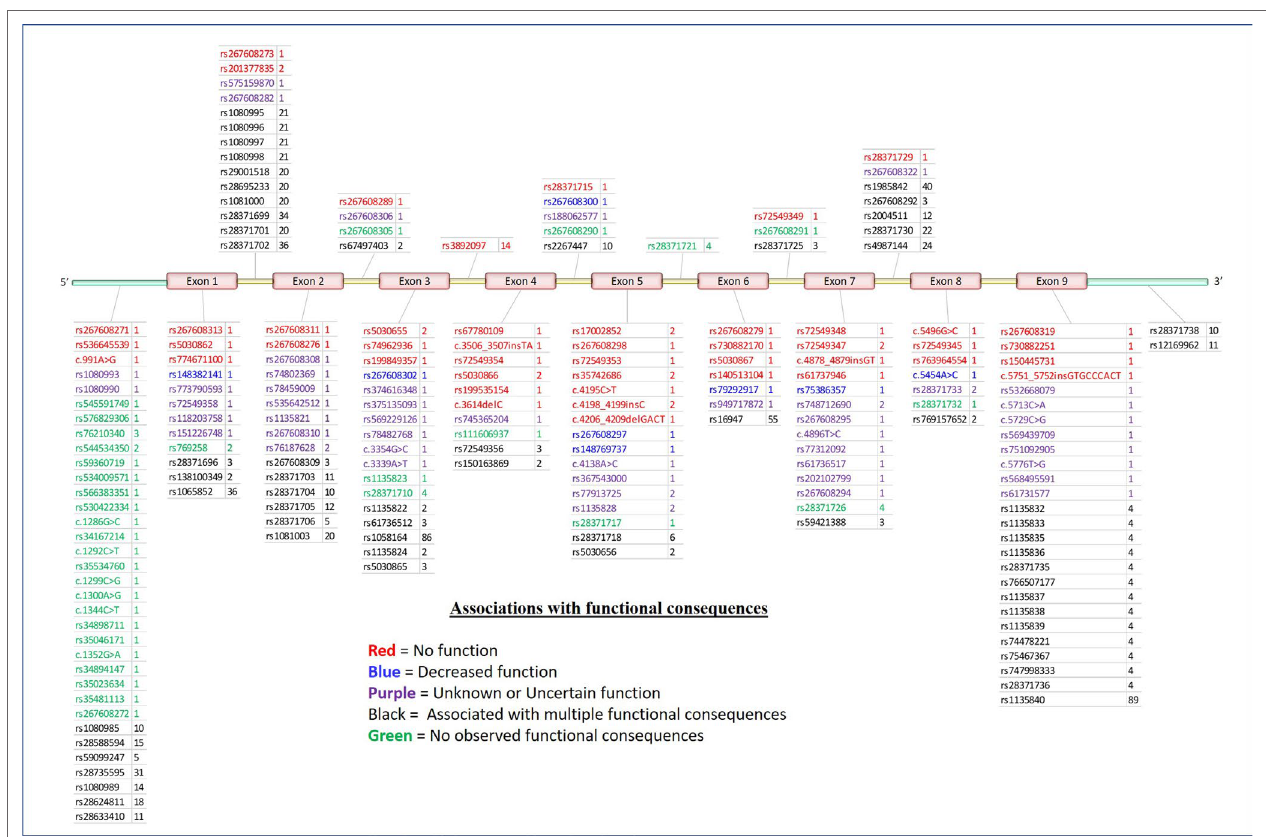
FIGURE 2 | 5 ′ to 3 ′ structure of the CYP2D6 locus and placement of variants. Physical position of known pharmacogenomics (PGx) variants in CYP2D6 by rsID (total N = 198). Colors indicate putative functional consequences: red = no function, blue = decreased function, purple = unknown or uncertain function, black = single-nucleotide polymorphism (SNPs) with multiple associated functional consequences [e.g., rs1135840 can be found in alleles with normal function, decreased function, and even non-functional (e.g., *35 , *17 , and *4 , respectively)], green = no observed functional consequences to date (normal). Numbers to the right of each rsID indicate the total number of haplotypes (* alleles) on which each variant is known to be